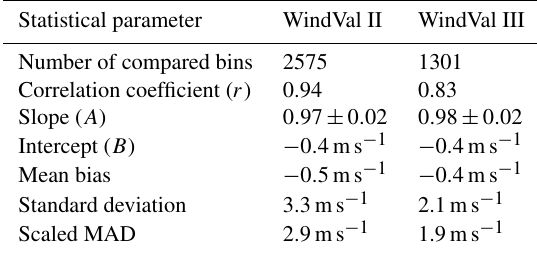
Table 3. Results of the statistical comparison between the A2D Rayleigh channel and the 2µm DWL wind data for all flights performed during the WindVal II campaign in 2016 and the WindVal III campaign in 2018. See the corresponding scatterplots in Fig. 6. The values are given as wind speeds measured along the A2D LOS. (MAD refers to median absolute